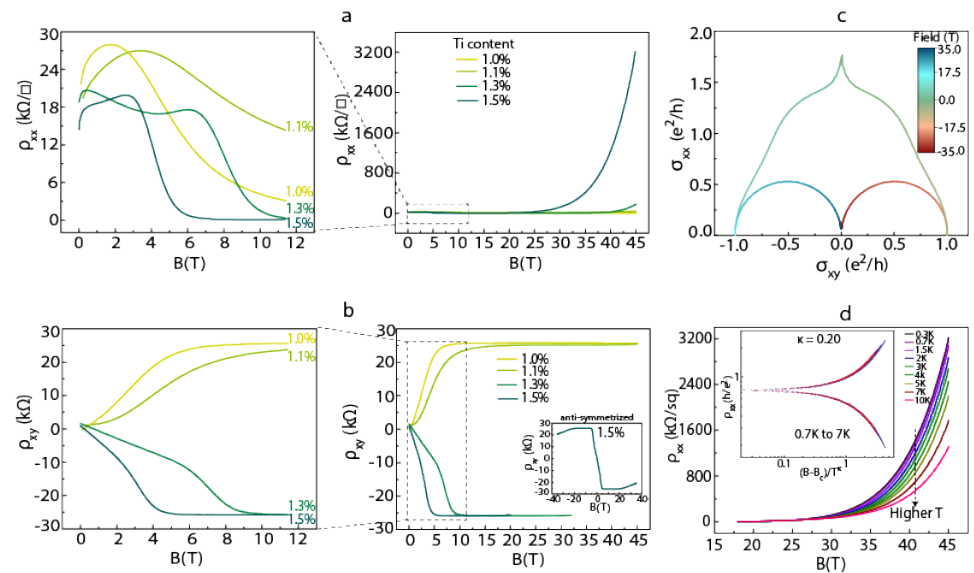
Te TI films . a, Figure 4: QHE in MBE-grown ultra-low-Fermi-level Ti-doped Sb 2 3 Magnetic field (0 to 45 T) dependence of ρ for 8 QL thick interface-engineered xx Sb Te films with 1%, 1.1% 1.3% and 1.5% Ti. The left panel shows 0 < B < 11 2 3 , / 15 QL-(Sb T. All the films are grown on 20 QL-In Se In ) Te BL and capped 2 3 0.65 0.35 2 3 with 15 QL SIT. b, Magnetic field (0 to 45 T) dependence of ρ . The left panel shows xy 0 < B < 11 T. The inset in b (right panel) shows the anti-symmetrized Hall resistivity of the 1.5% sample. c, The conductivity tensor flow plot ( σ vs. σ ) for the 1.5% xx xy sample at | B | < 35 T. Each point on this plot corresponds to extracted ( σ , σ ) for xy xx each field. The field is incorporated as a color map in the plot. The points ( e 2 / h ,0) corresponds to the QH state, (0,0) corresponds to the (Hall) insulator phase, and (0.5 e 2 / h , 0.5 e 2 / h ) corresponds to the critical point of the transition between these two phases. The cusp around zero field indicates weak anti-localization. d, ρ as a xx function of magnetic field for the 1.5% sample at temperatures 300 mK through 10 K: all the curves pass through one another at the critical magnetic field (B 23.9 T). c The inset graph is the corresponding temperature scale-invariant plot, yielding κ = 0.20 ± 0.02. These figures are adapted from ref. [ 60